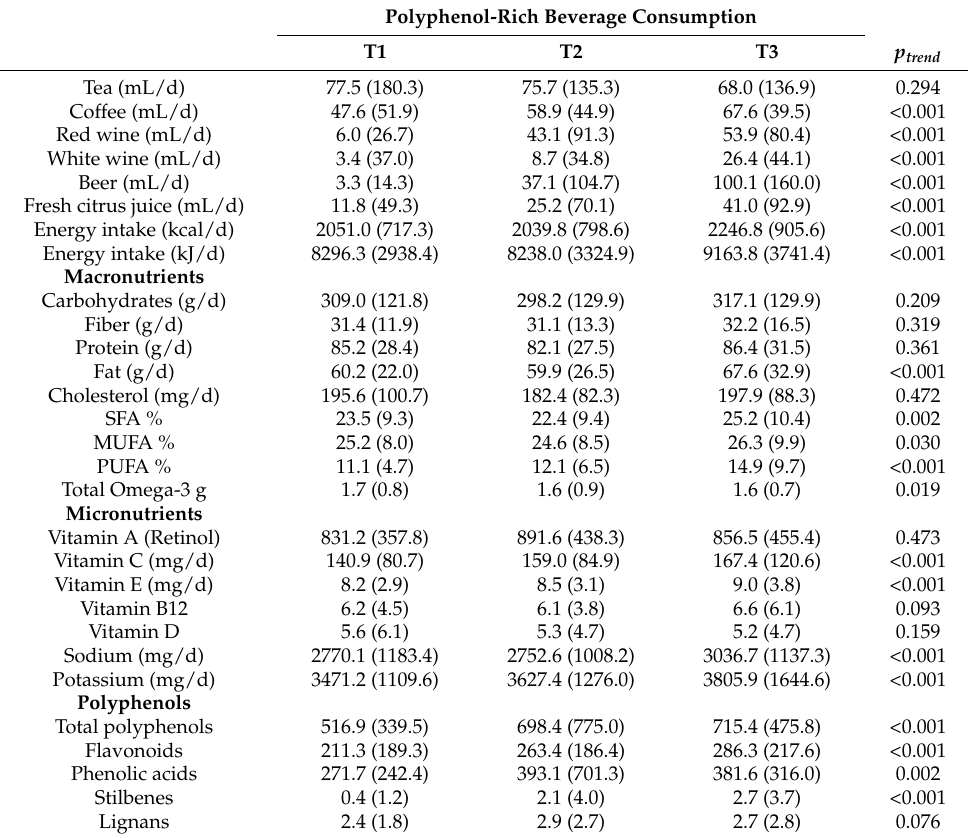
Results are expressed as mean (SD).